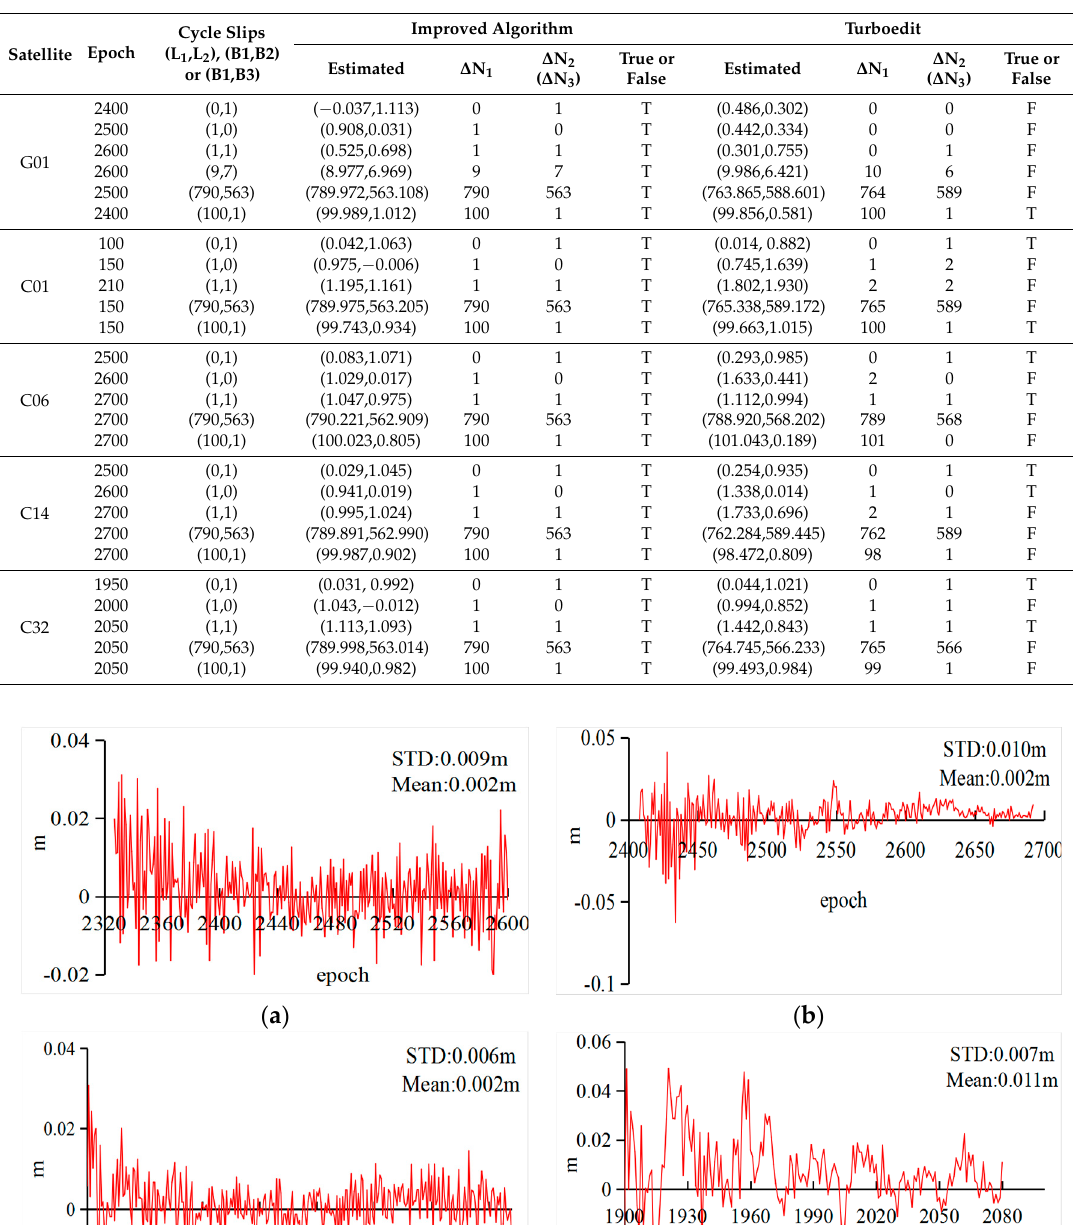
Table 4. Results of GPS (G01), three types of BDS-2 (C01, C06, C14), and the BDS-3 experimental satellite (C32) based on the improved algorithm and Turboedit for DOY 183 in LHA1 (cycle).